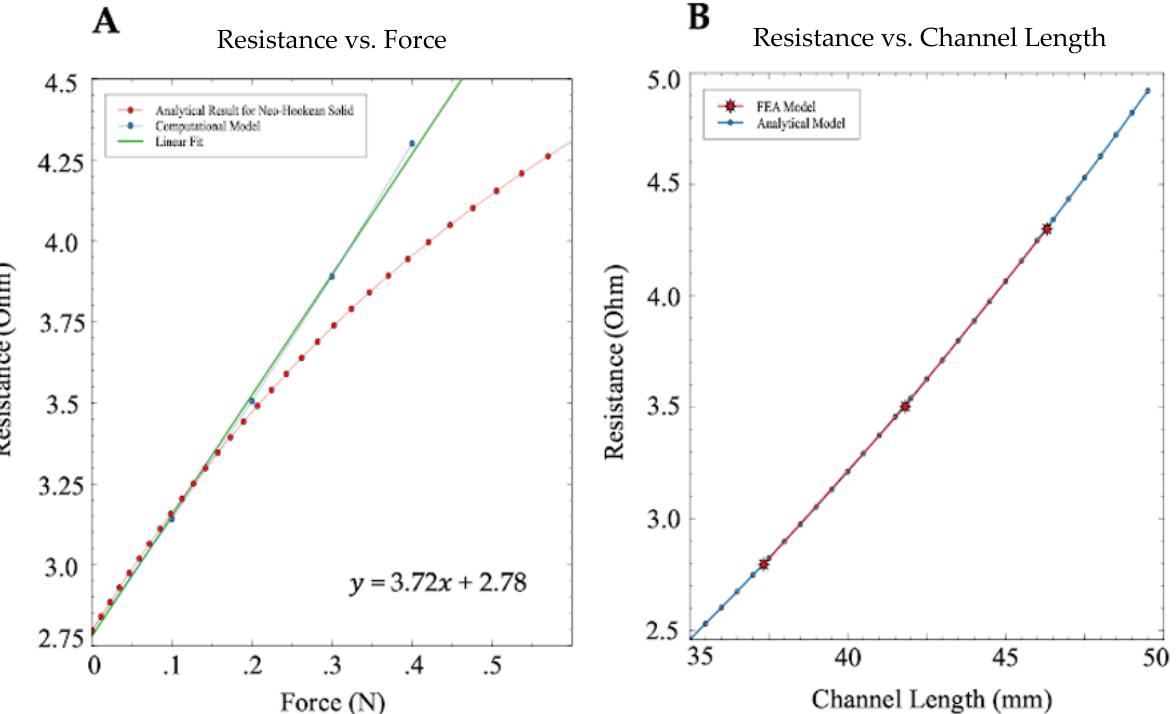
Figure 5. ( A ) Resistance vs. force relationships found through FEA modeling and analytical approaches. Matlab’s curve fitting application was used to create the linear approximation, with the equation of the line displayed on the bottom right-hand side. The range of highest ablation success rate (0.1–0.2 N) displays high agreement between the two models. ( B ) The resistance vs. channel length trends for both the analytical and FEA models are plotted above. The FEA model values are based on applied force values (starting left, going right) of 0, 0.2, and 0.4 N .